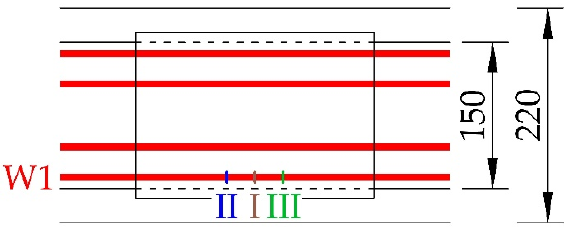
Figure 12. Scheme of MBN measurement (Specimen 4; Wire 1).